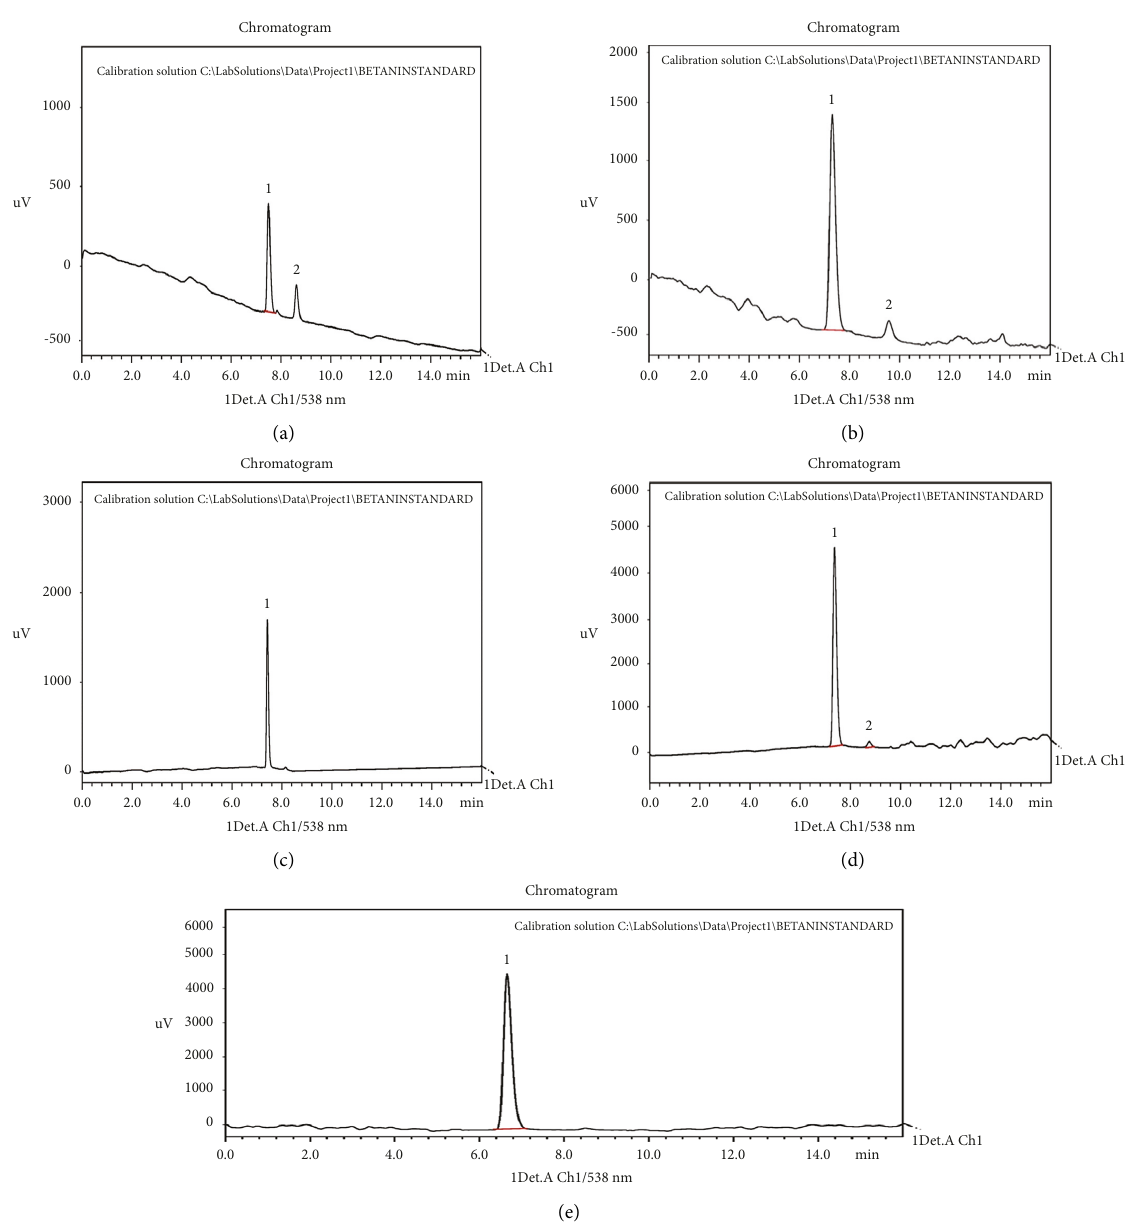
Figure 2: Chromatograms for the betanin standard (betanidin 5- β -D-glucopyranoside) at 10ppm (a), 15ppm (b), 20ppm (c), 27 ppm (d), and 35ppm